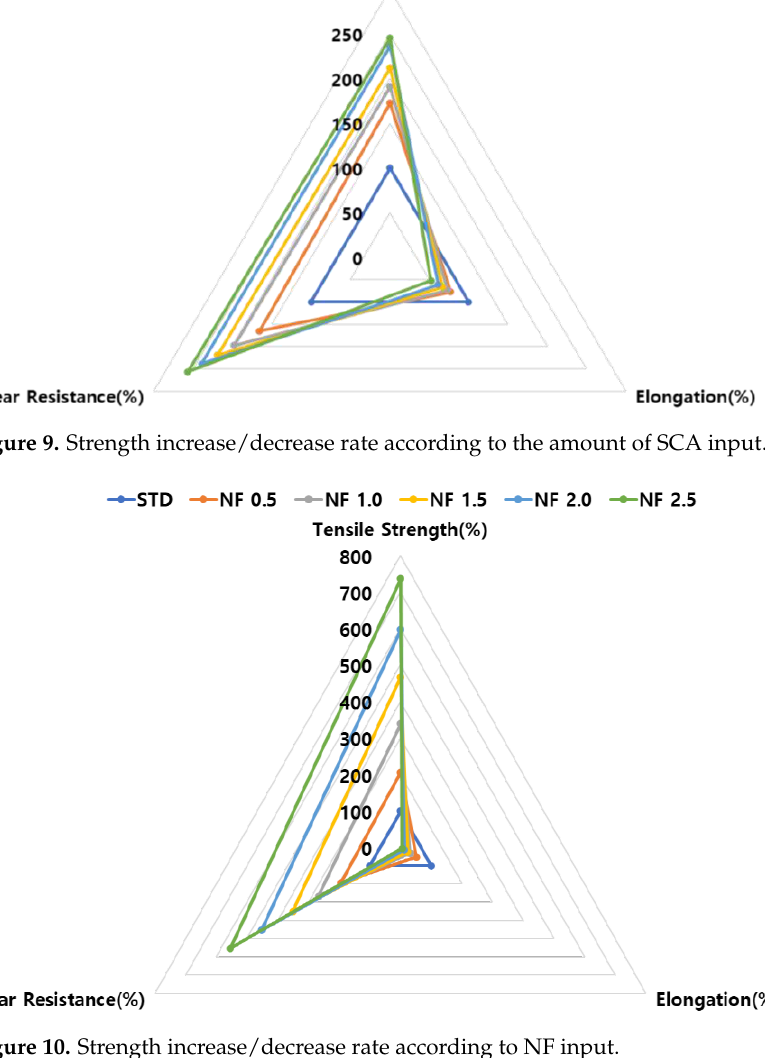
Figure 11. Strength increase/decrease rate according to EVA input amount.